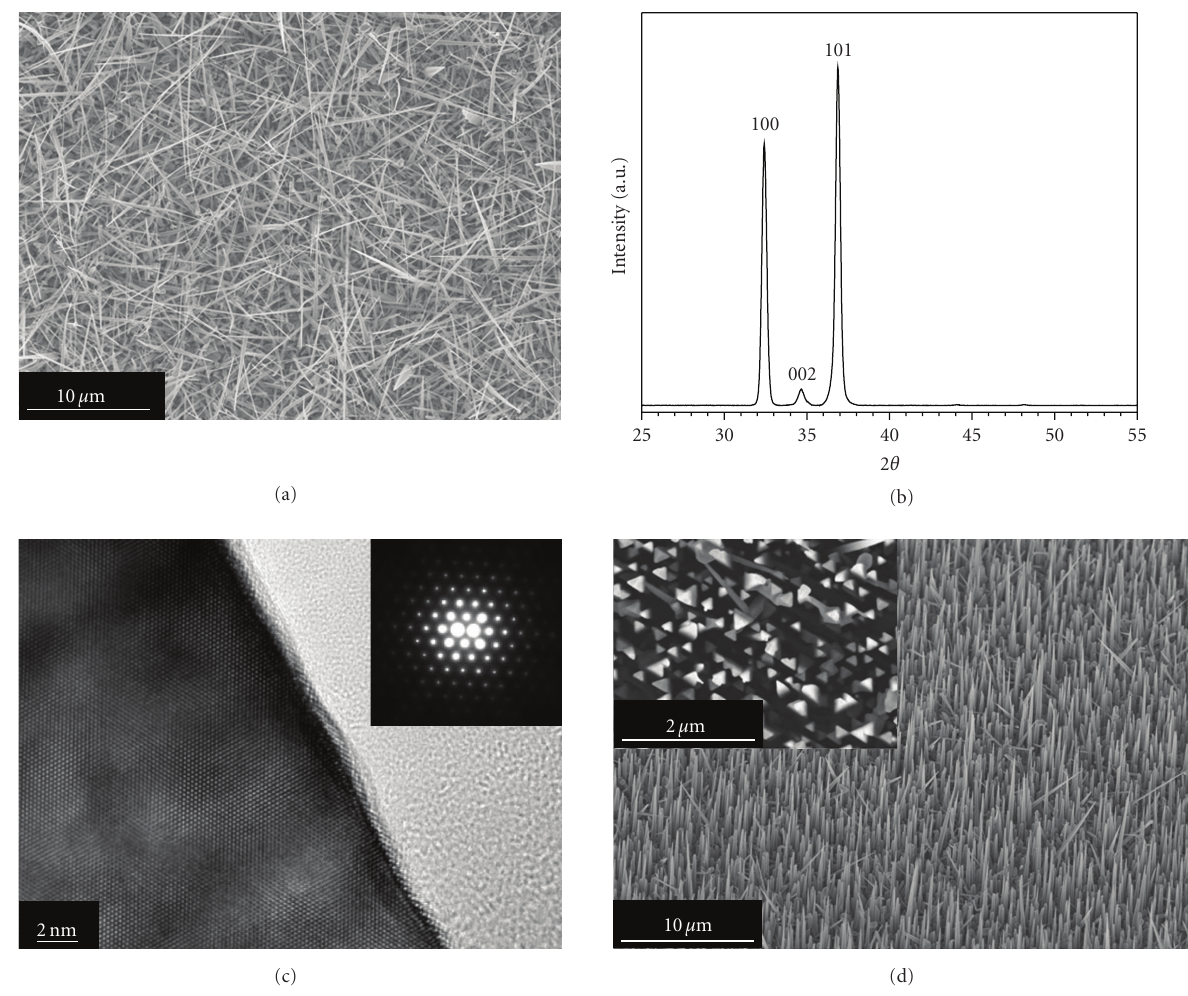
Figure 1: (a) SEM image of GaN nanowires grown with NiNO 3 catalyst on c-Al 2 O 3 substrate. The wires have random orientation with diameters from 50 to 500 nm, and lengths on the order of 10 to 20 μ m. (b) XRD of the GaN nanowires indicates that it has the wurtzite crystal structure. The peaks shown correspond to the (100), (002), and (101) planes from left to right. (c) TEM phase contrast image of a single GaN nanowire oriented along the [001] zone axis. The wires length extends along the [210] direction. The inset shows the electron di ff raction pattern, indicating that the wires are single crystalline. (d) SEM showing vertically aligned GaN nanowires on a-LiAlO 2 tilted 30 ◦ . The inset shows the triangular cross-section of the nanowires from the top-down view.